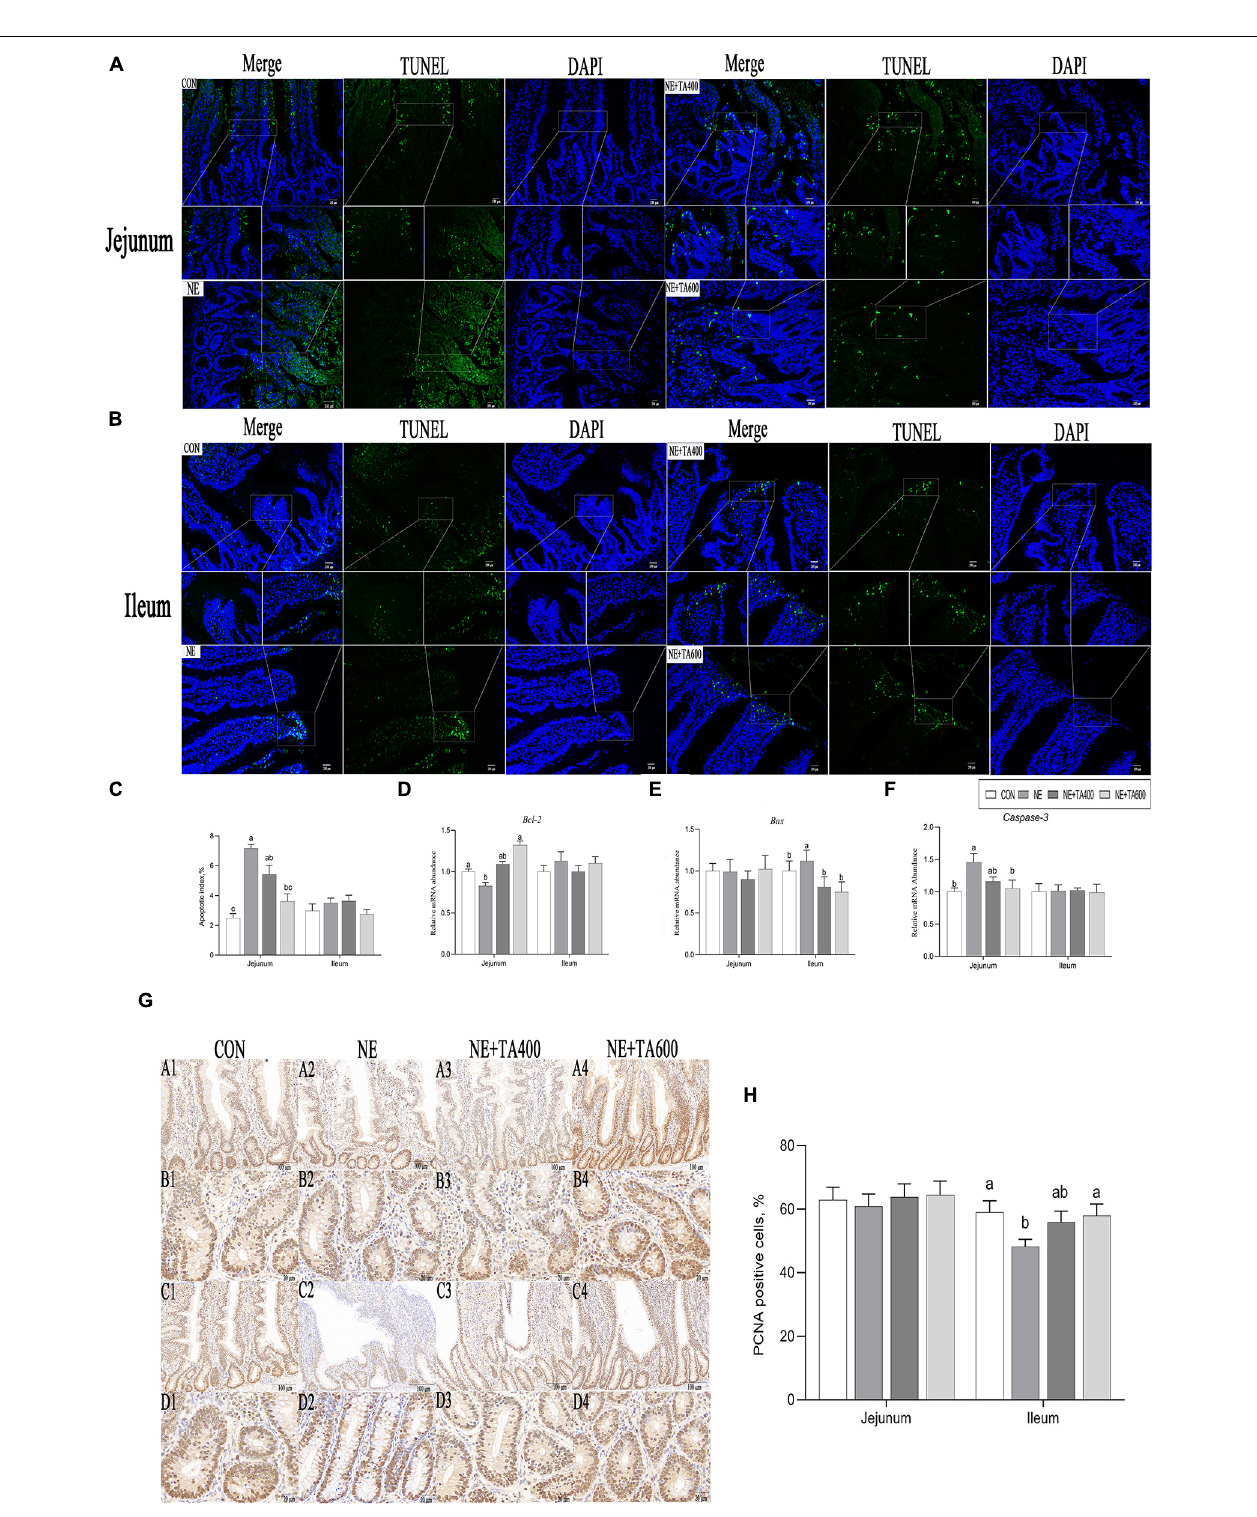
FIGURE 3 | Effects of TA on intestinal apoptosis and proliferation of subclinical NE broilers. (A–C) Jejunal and ileal TUNEL apoptosis and apoptotic index, (D–F) jejunal and ileal mRNA abundance of apoptotic genes, (G,H) jejunal and ileal proliferating cell nuclear antigen (PCNA) staining and numbers of PCNA-positive cells (PCNA-positive cells/total numbers of cells × 100). Values were expressed as mean with standard error represented by vertical bars. a , b Means with different letters differ significantly among the groups ( P < 0.05). Bcl2 , B-cell lymphoma/leukemia 2; Bax , Bcl2-associated X; PCNA, proliferating cell nuclear antigen.